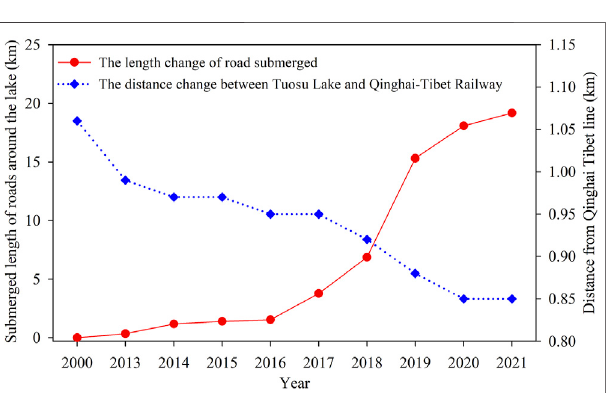
FIGURE 8 | Length change of the road submerged and the distance change between Tuosu Lake and the Qinghai – Tibet Railway.